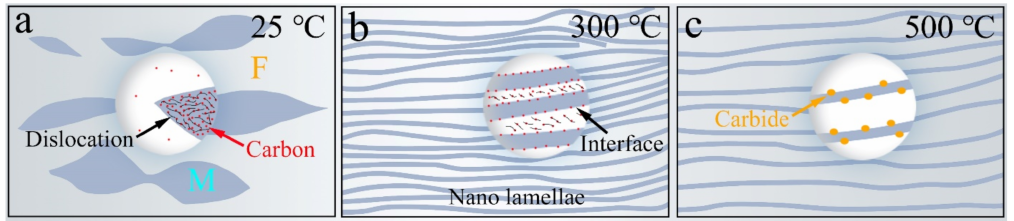
Figure 6. Schematic illustration of the responses of carbon atoms in martensite at different rolling temperatures: ( a ) 25 ◦ C, ( b ) 300 ◦ C, ( c ) 500 ◦